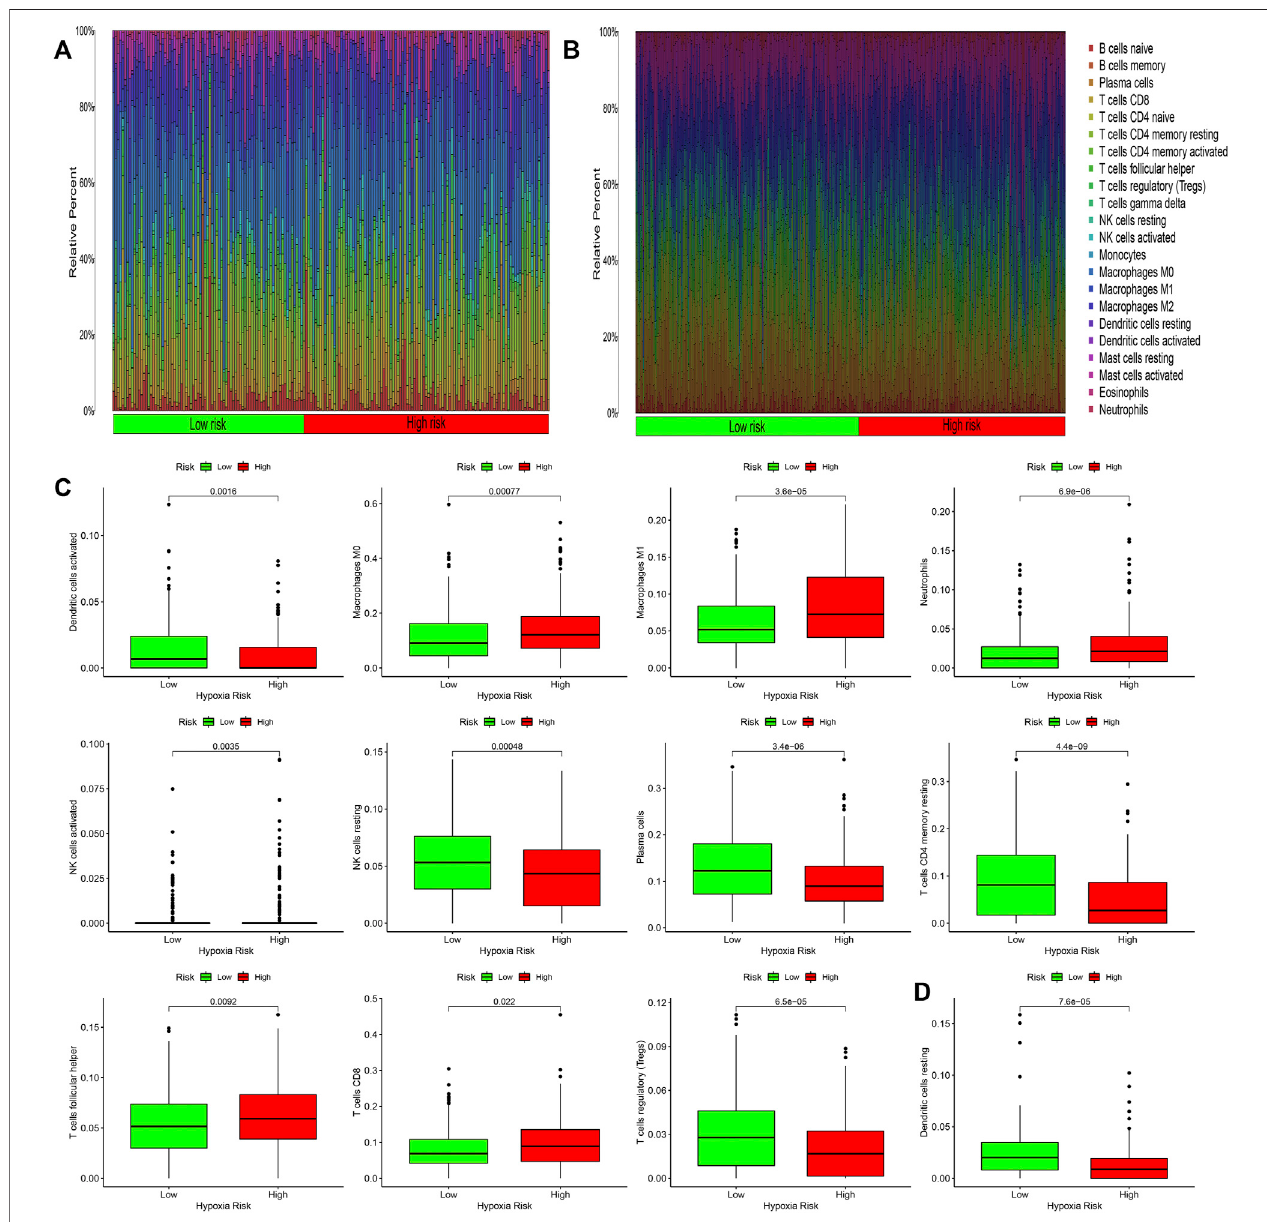
FIGURE 6 | Immune cell in fi ltration in high and low risk groups. (A,B) Thermography of in fl ammatory response-related gene risk scores and immune cell in fi ltration in the TCGA and GEO databases. (C,D) In fi ltrating immune cells in the TCGA and GEO databases were signi fi cantly associated with the risk scores.